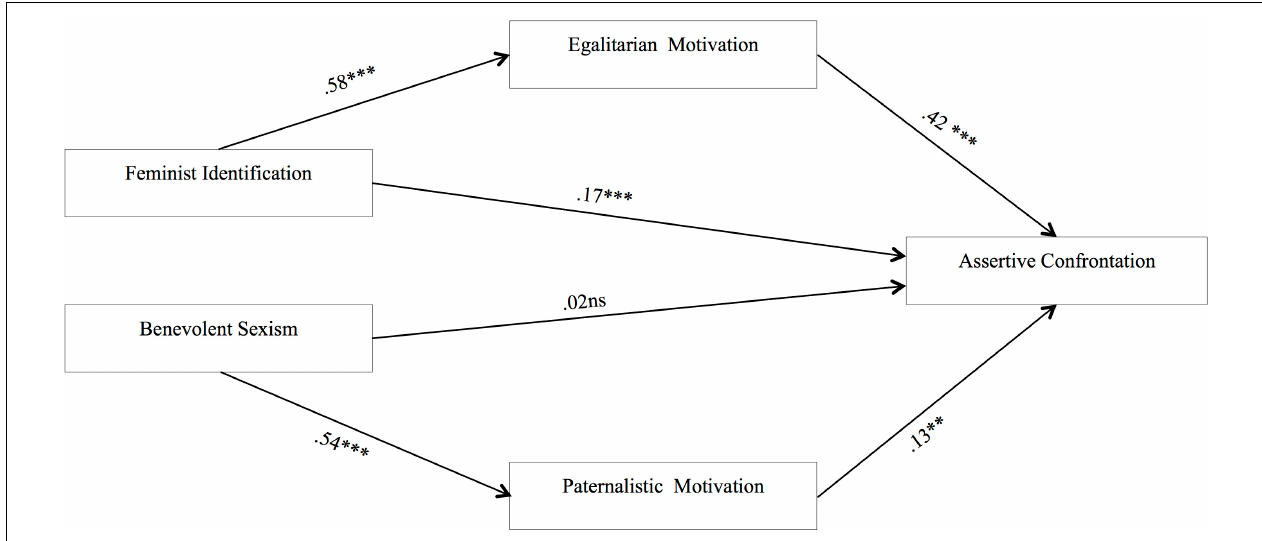
FIGURE 2 | Path analysis with pooled data of Studies 1–3 to test simultaneously the two motivational processes (feminist and paternalistic path) underlying men’s future intensions to confront. ∗ p < 0.05, ∗∗ p < 0.01, ∗∗∗ p < 0.001.